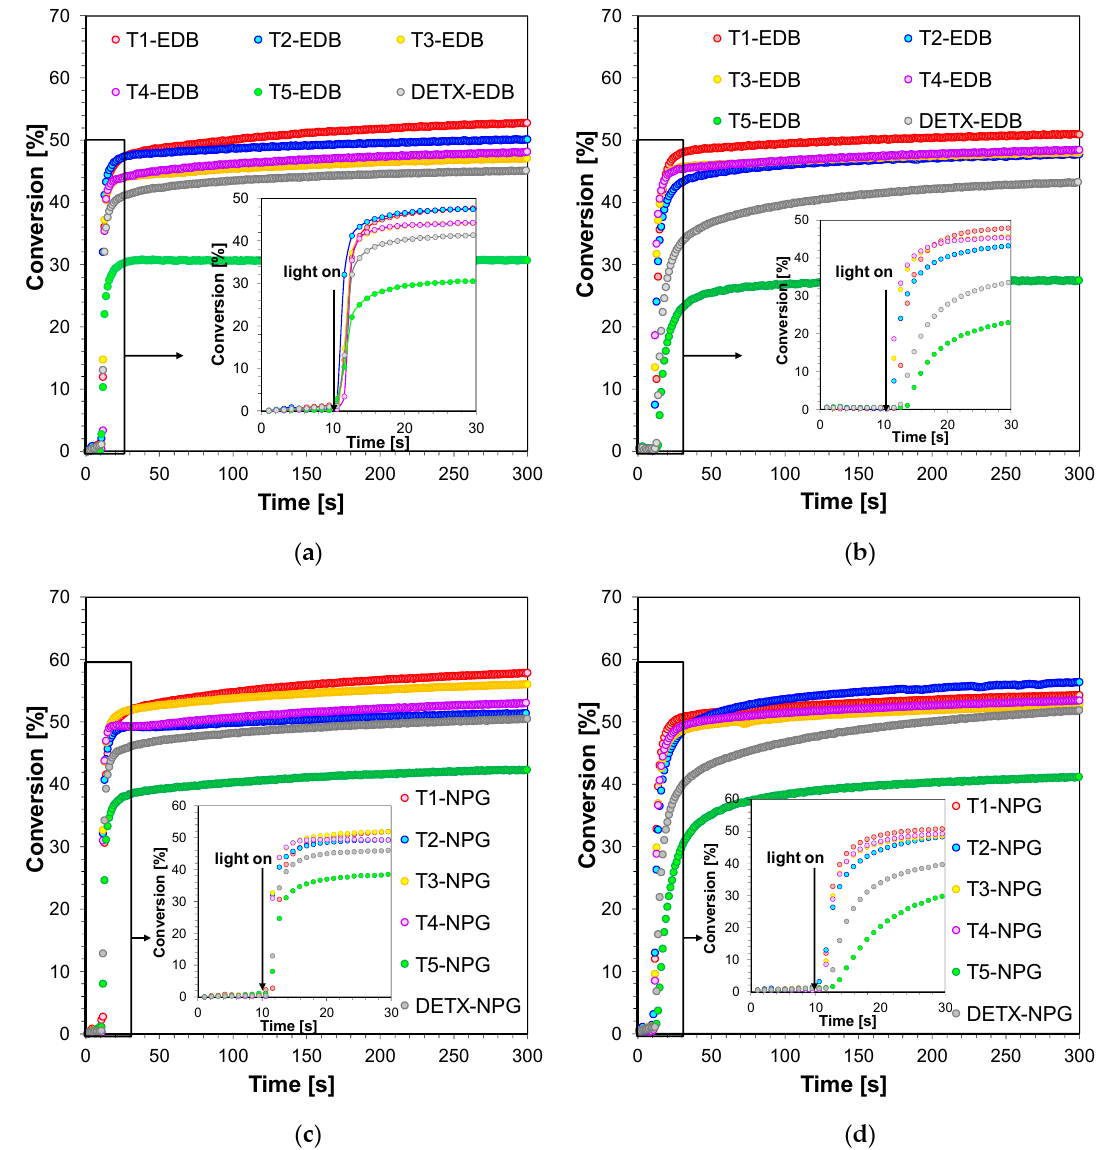
Figure 8. Polymerisation profiles of TMPTA (acrylate function conversion vs. irradiation time) in laminate in the presence of different photoinitiating systems based on EDB (1.5% w / w ) and 2,4-diethyl-thioxanthen-9-one derivatives (0.2% w / w ) upon exposure to ( a ) the visible LED@405 nm, ( b ) to the visible LED@420 nm. Polymerisation profiles of TMPTA (acrylate function conversion vs. irradiation time) in laminate in the presence of different photoinitiating systems based on NPG (1.17% w / w ) and 2,4-diethyl-thioxanthen-9-one derivatives (0.2% w / w ) upon exposure to ( c ) the visible LED@405 nm, ( d ) the visible LED@405 nm. The irradiation starts at t = 10 s.